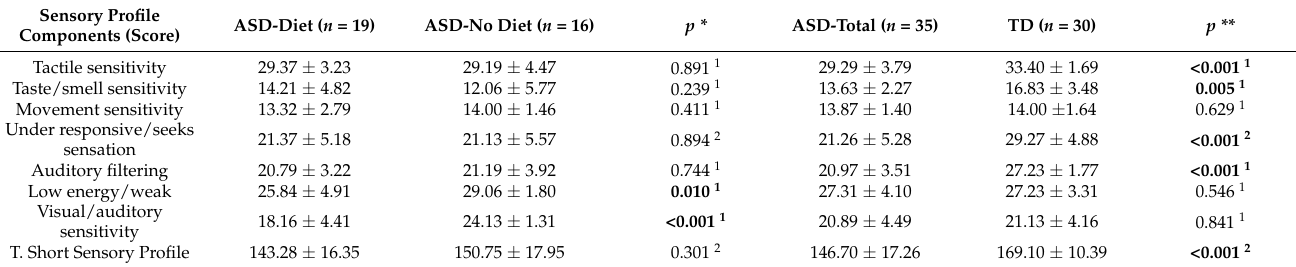
Table 2. Sensory profile in children with autism spectrum disorder and typical